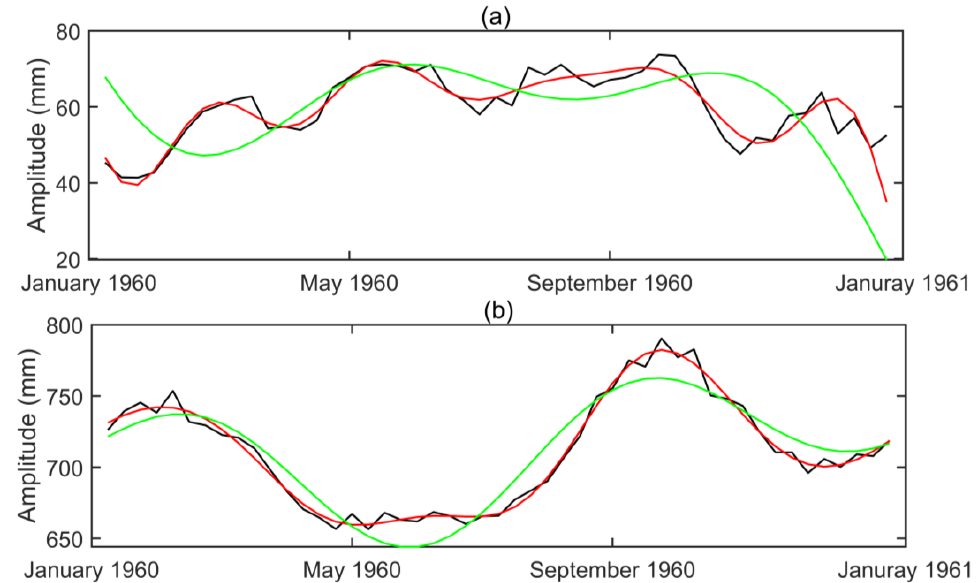
Figure 5. ( a ) The observed (black line) and fitted (red line) weekly M 2 amplitudes at Hondau. Green line represents the fitted results without subseasonal cycles. ( b ) Same as ( a ), but for K 1 tide.